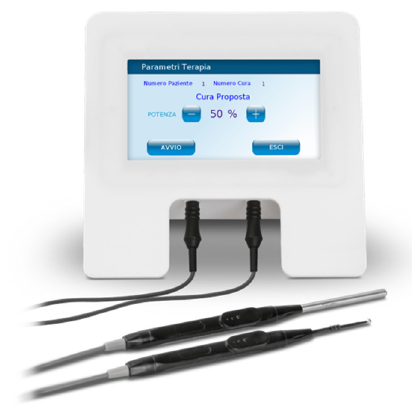
Figure 2. Picture of the market-ready device.